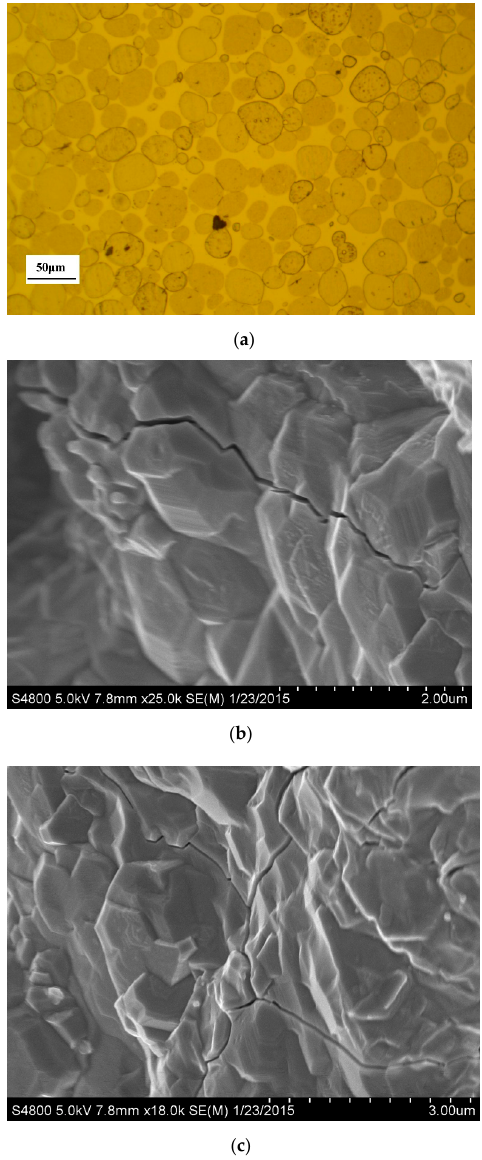
Figure 5. Microstructures in recovered 90W–9Ni–Co alloy liner. ( a ) Original structure captured by metalloscope. ( b ) Crack distribution on the fracture surface. ( c ) Crack pattern around tungsten particles.